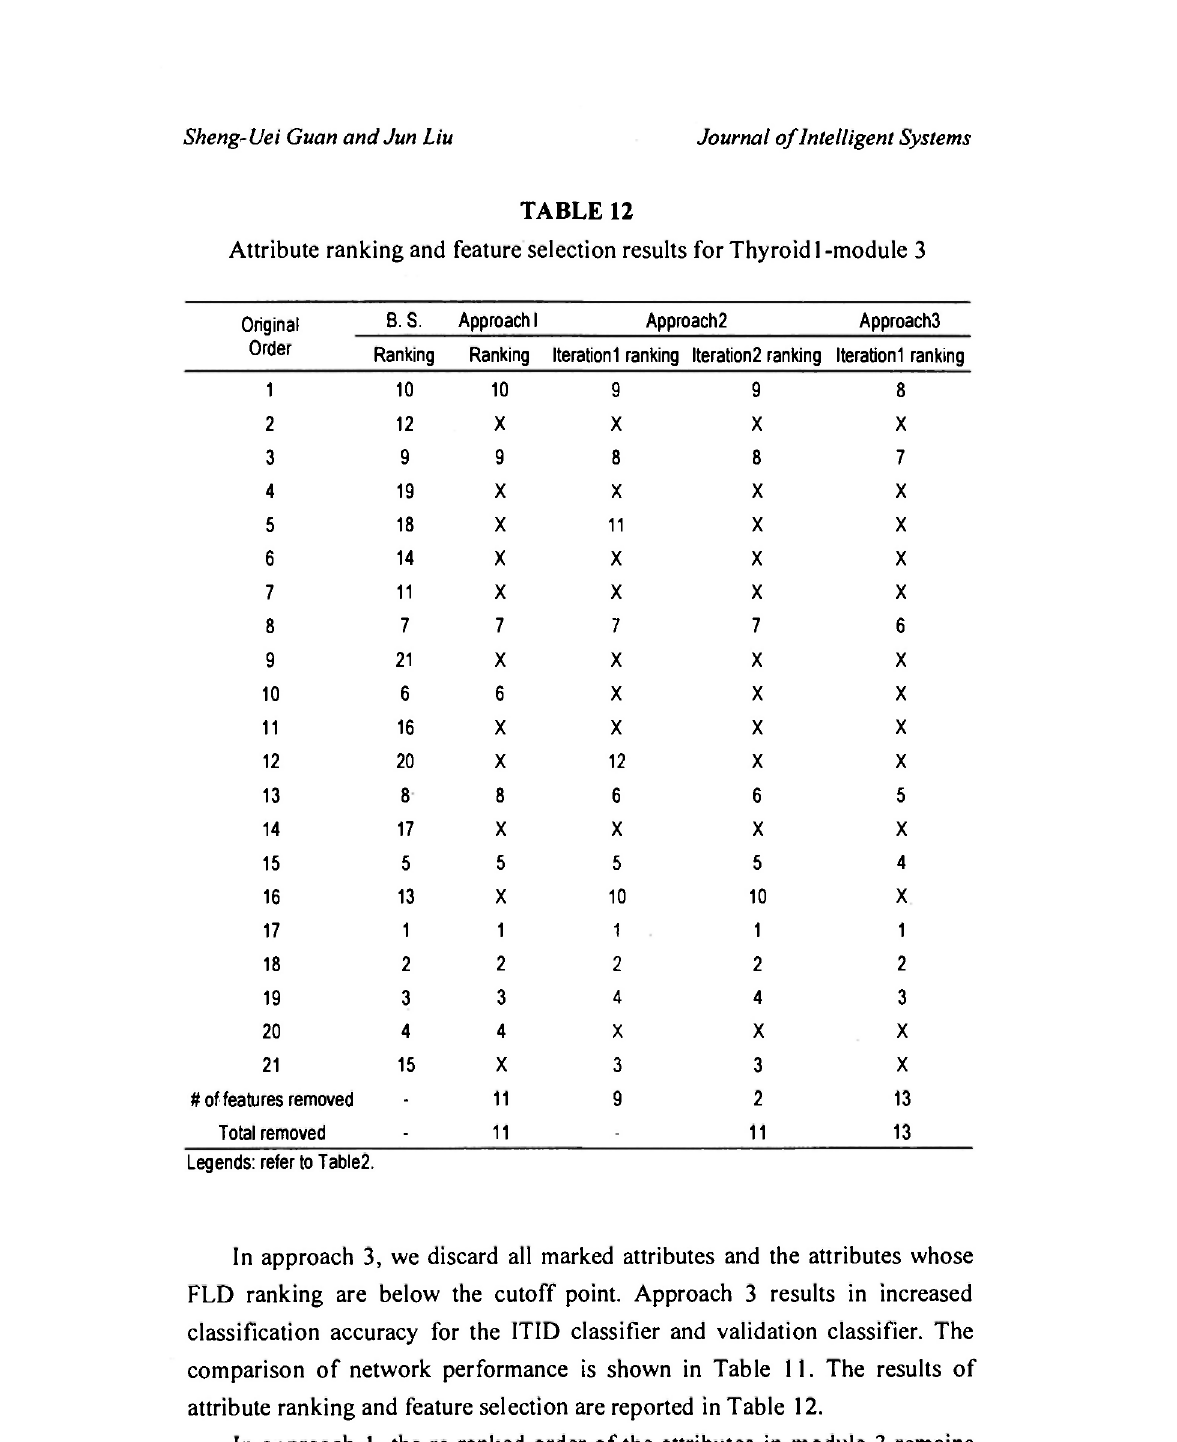
Attribute ranking and feature selection results for Thyroid 1 -module